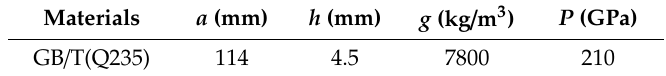
Table 1. Materials and geometric parameters of the experimental